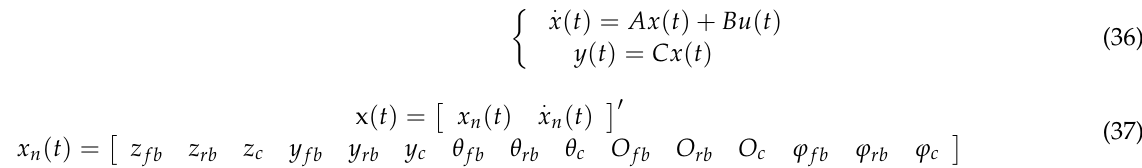
As shown in Figure 15, the mathematical model of the capsule vehicle was composed